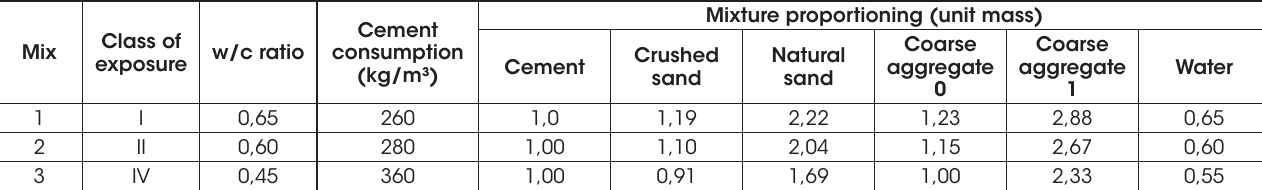
Mix proportion defined for the environmental exposure classes